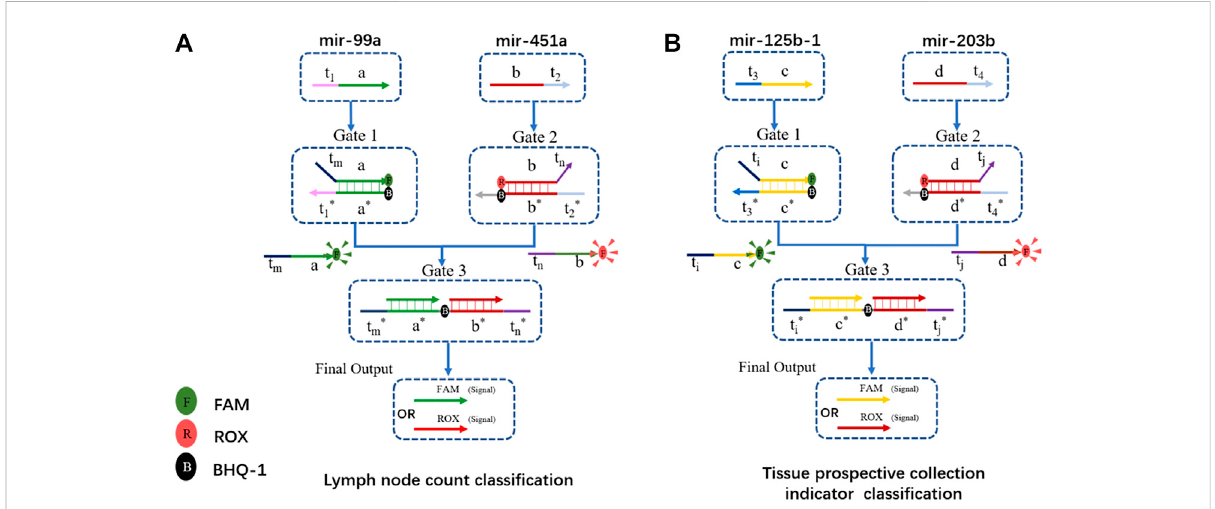
FIGURE 7 DSD-based DNA computing system for functional classi fi cation. (A) Gene biomarkers mir-99a and mir-451a for lymph node examined count classi fi cation. FAM and ROX were attached to the fi nal output strand. FAM/ROX dominates the high/low expression of lymph node counts. (B) Gene